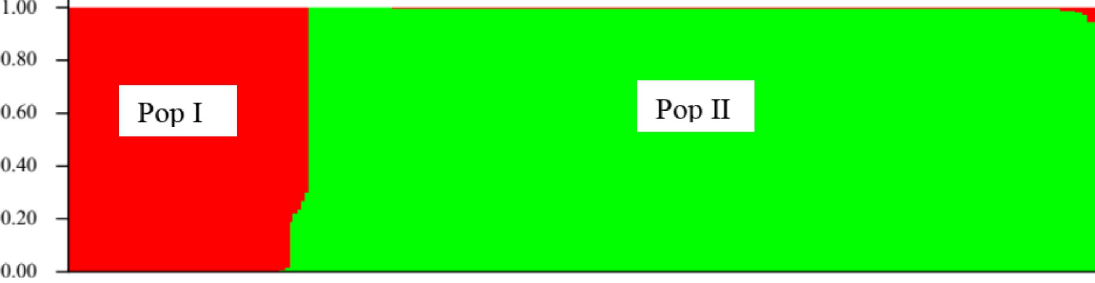
Fig 3. Barplot of populations sorted by Kinship matrix (Pop I = population I, Pop II = population II).